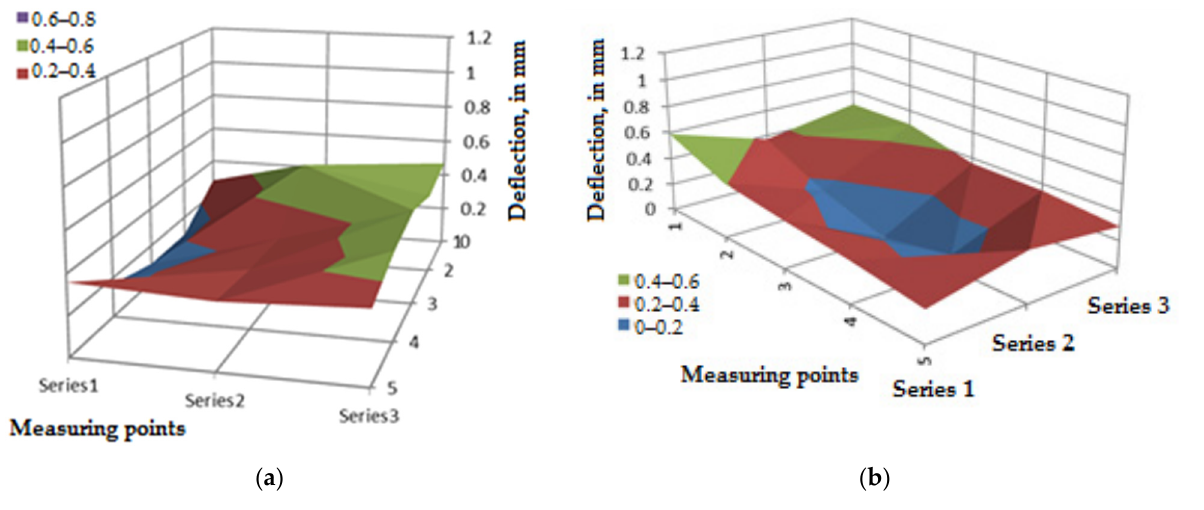
Figure 7. Deflection values and warpage of blockboard with veneer (V) faces tested in the climatic chamber: ( a ) at the beginning of the experiment; ( b ) after three months of exposure in the climatic chamber.